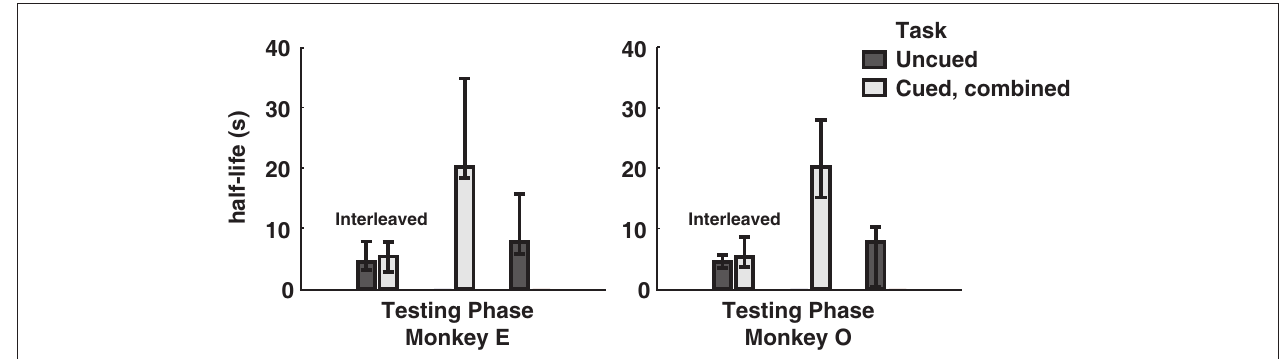
Figure 4 | Model-averaged half-lives for both monkeys over the course of training. In early sessions, cued and uncued conditions were interleaved in blocks of several hundred trials. Following this, both monkeys received several sessions of the cued condition only, followed by a return to the uncued